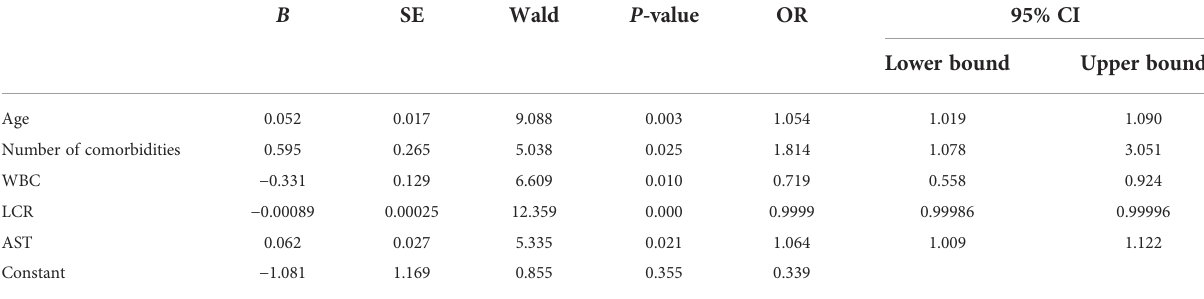
TABLE 3 Analysis of the related factors to classify COVID-19 patients into moderate, severe, and critical groups. B SE Wald P -value OR 95% CI Lower bound Upper bound